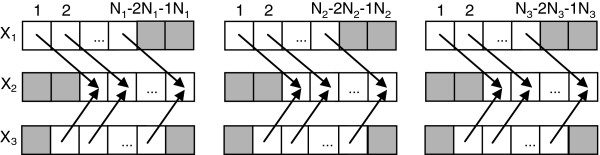
Data alignment for nodeX2 in the DBN in Figure1(c). Shaded cells denote unused observations for the calculation of Is(X2,Pa2).